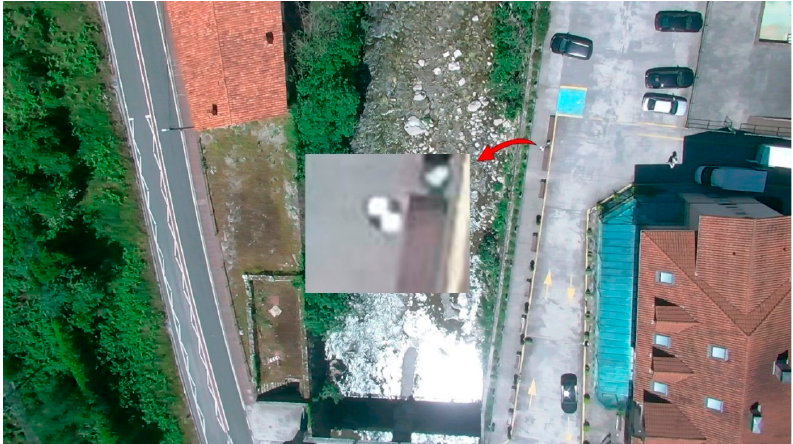
Figure 4. Detail of a GCP on RGB image.